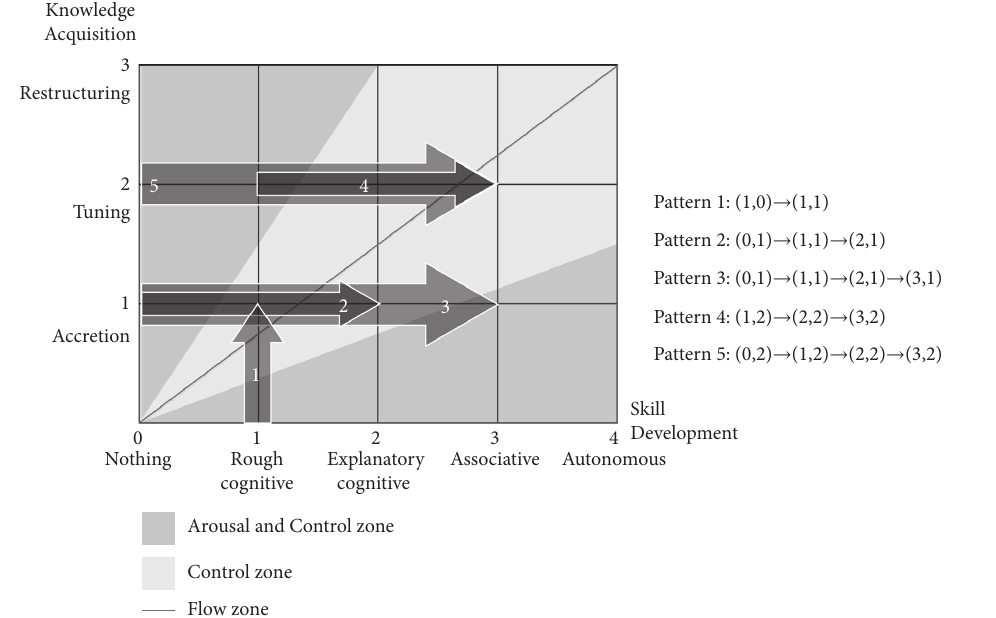
Figure 5: Five growth process patterns contributing to optimal gamification learning